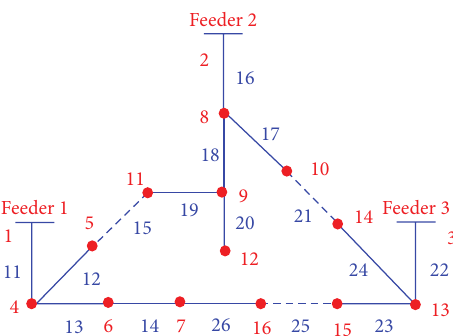
Figure 4: Distribution network after crossover.